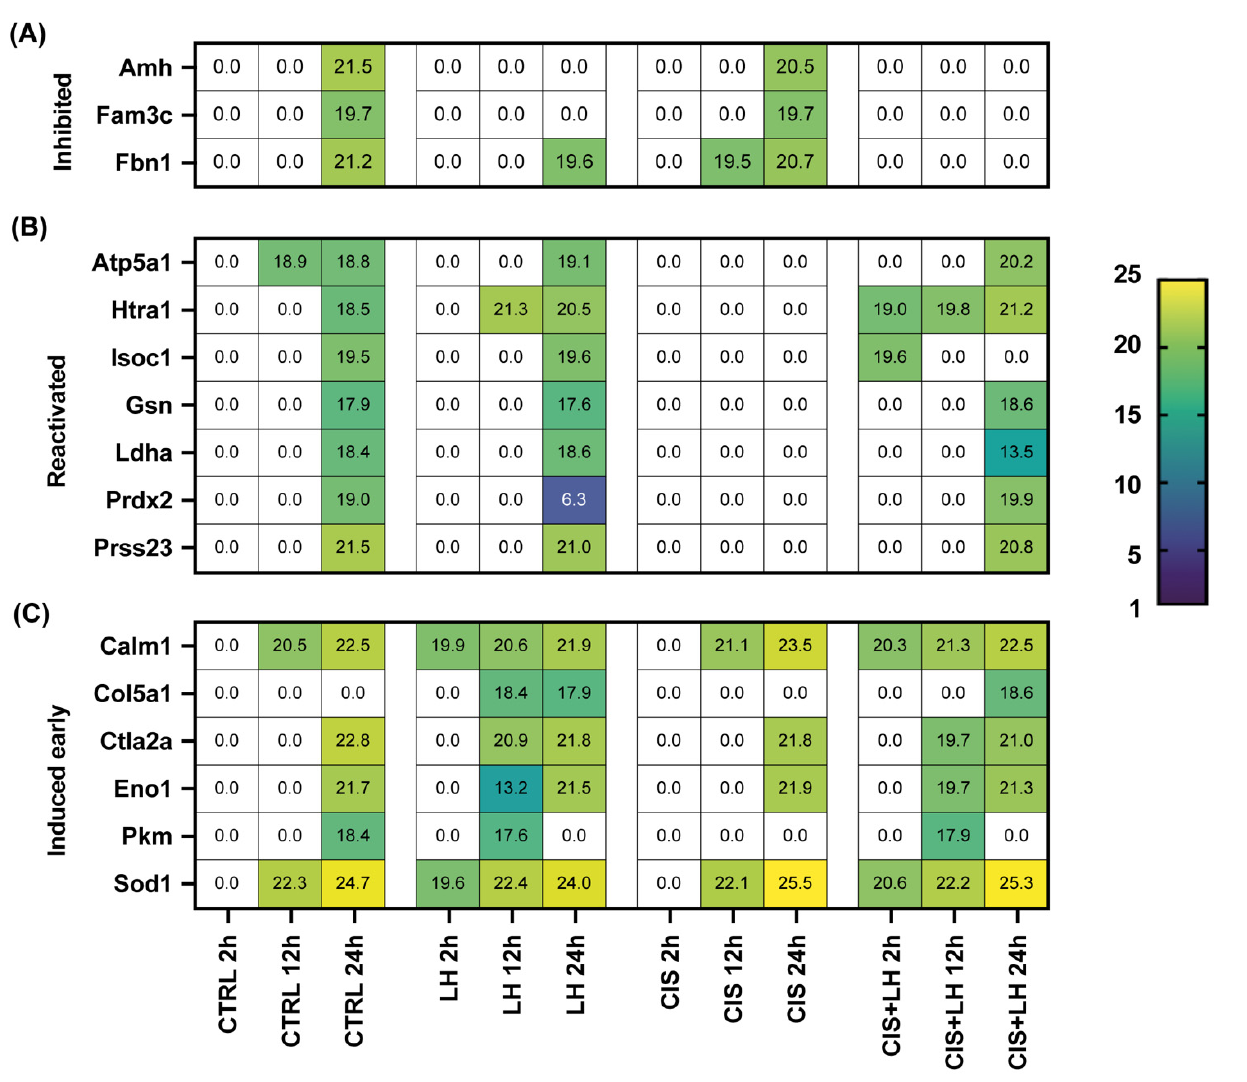
Figure 7. Heatmap comparison of the Mean log 2 iBAQ values of metabolites hypothetically impli- cated in the protective effect of LH against CIS-induced apoptosis. LH was able to ( A ) inhibit the expression and/or the release in the microenvironment of probable proapoptotic factors induced by CIS in the ovarian tissues (Inhibited); ( B ) reactivate those of several antiapoptotic factors inhibited by CIS (Reactivated); ( C ) anticipate the induction of other (Induced early).